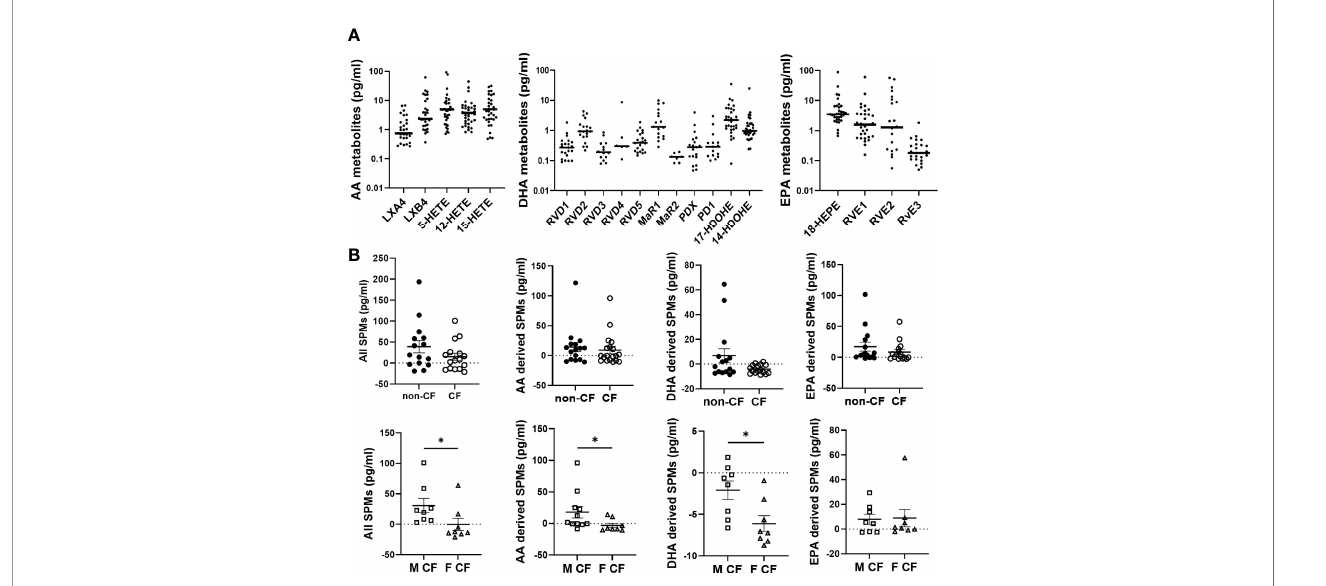
FIGURE 1 | Lipid mediators detected in CF and non-CF hNEC culture medium. (A) Raw values of arachidonic acid (AA), docosahexaenoic acid (DHA) and eicosapentaenoic acid (EPA) metabolites measured in the basolateral culture medium of CF and non-CF hNEC. (B) Comparison of the cumulative levels of all lipid